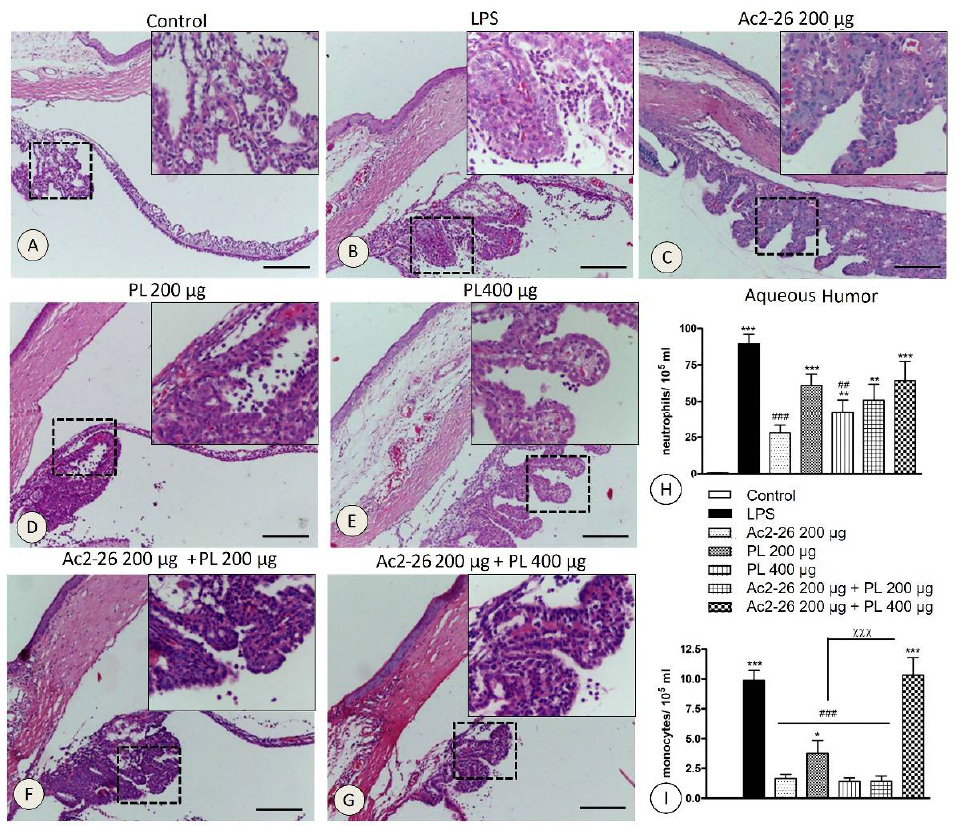
Figure 2. Histopathological analyses of ocular tissues in EIU . Absence of leukocytes in control tissues ( A ). Influx of neutrophils after 24 h LPS ( B ) and treated with Ac2-26 + PL 400 µg ( G ). Significant decrease in cellular extravasation after systemic treatments with Ac2-26 ( C ) and PL 400 µg ( E ) and moderate inflammatory influx reduction after treatments with PL 200 µg ( D ) and Ac2-26 + PL 200 µg ( F ). The details show enlargements of dashed areas. Sections: 5 µm, stain: HE, bars: 100 µm. Quantitative analyses of neutrophils ( H ) and monocytes ( I ) in the aqueous humor. The data show mean ± SEM of neutrophils and monocytes × 10 5 mL in the eyes of control, untreated (LPS), and treated (Ac2-26 200 µg, PL 200 µg, PL 400 µg, Ac2-26 + PL 200 µg, and Ac2-26+ PL 400 µg) rats ( n = 10 animals/group). *** p < 0.001, ** p < 0.01, and * p < 0.05 versus control; ### p < 0.001 and ## p < 0.01 versus LPS; and χχχ p < 0.001 versus Ac2-26 200 µg, PL 200 µg, PL 400 µg, and Ac2-26 200 µg + PL 200 µg.